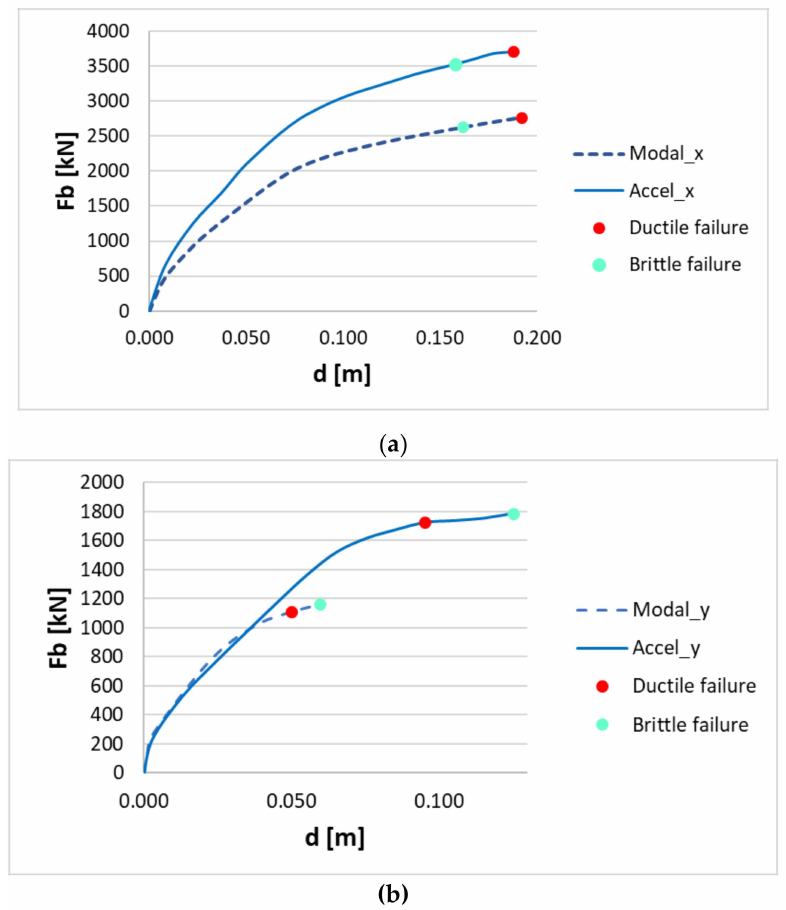
Figure 5. Capacity curves: ( a ) x-direction; ( b )